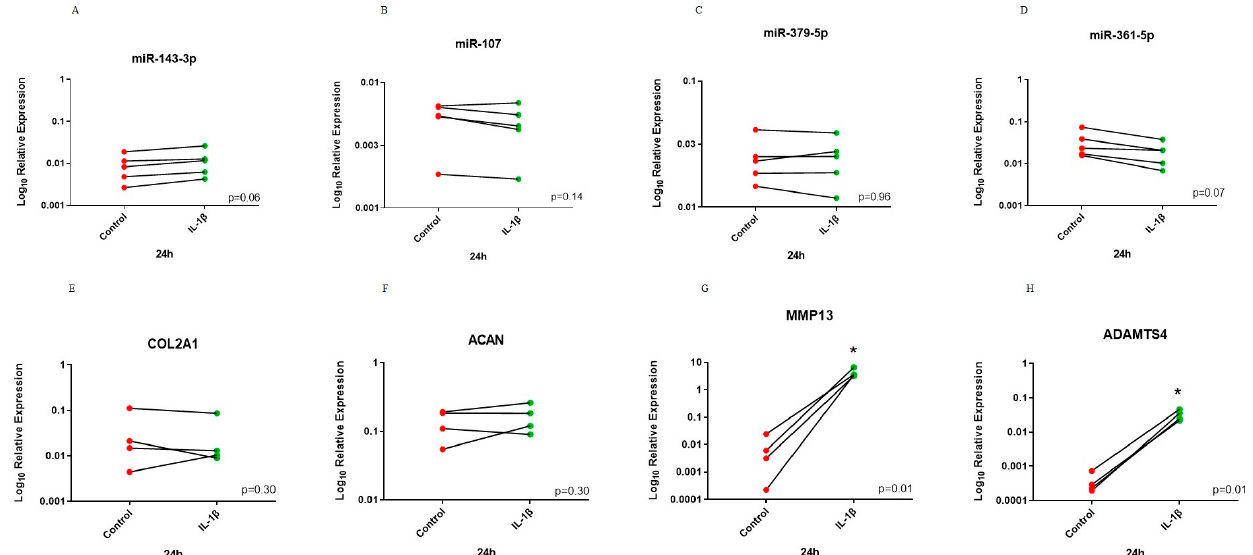
Figure 5. Before–after plot showing expression of selected miRNAs and cartilage markers in human OA chondrocytes treated with IL-1 β for 24 h. Human OA chondrocytes were treated with 10 ng/mL human recombinant IL-1 β or control for 24 h and expression of selected miRNAs; ( A ) miR-143-3p, ( B ) miR-107, ( C ) miR-379-5p and ( D ) miR-361-5p and cartilage markers; ( E ) COL2A1 , ( F ) ACAN , ( G ) MMP13 and ( H ) ADMATS4 was measured ( n = 4–5 donors). Y axis represents log-transformed ex- pression relative to SNORD68 for miRNAs and relative to GAPDH for OA markers. Statistical analysis was undertaken using a two-tailed paired t-test in GraphPad Prism (Version 8.0.1). p values < 0.05 were considered significant. *: p < 0.05. Each line connects the control (red) and treated group (green) of the same donor.